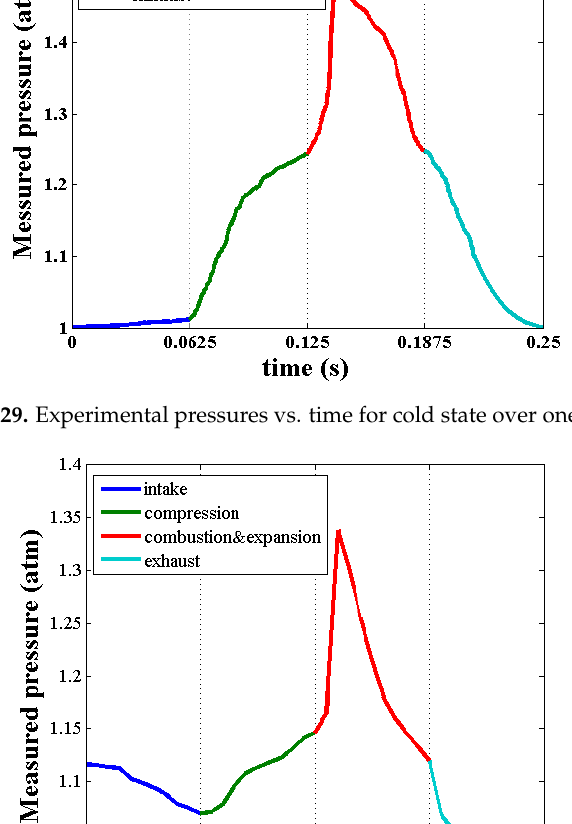
Figure 29. Experimental pressures vs. time for cold state over one cycle.